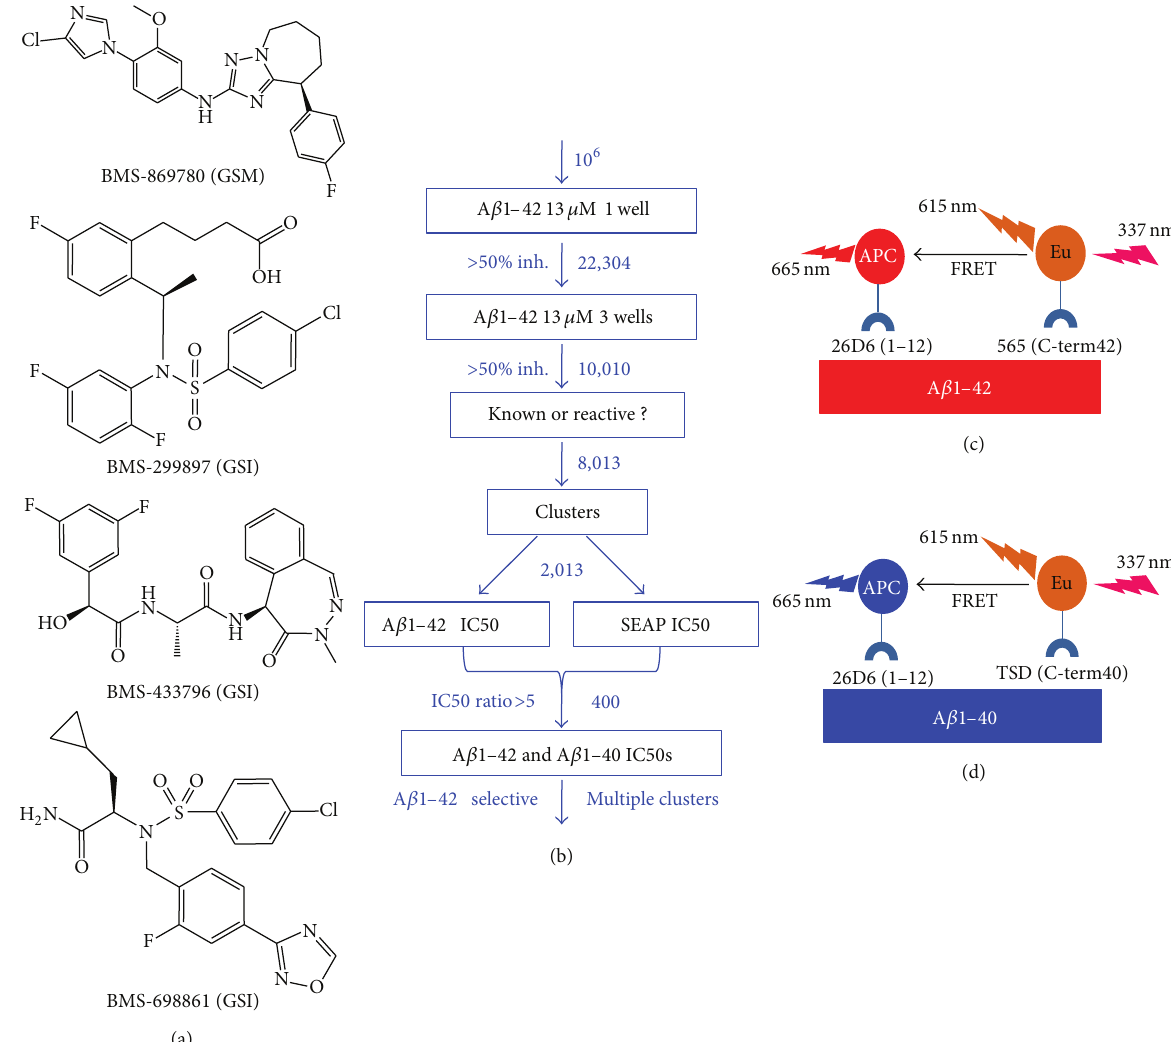
Figure 1: (a) Chemical structures of the compounds used in this study are shown. (b) Overview of the HTS and subsequent triage of compounds summarizes experimentation steps in boxes, with outcomes indicated beside the arrows. Costs of reagents and disposables were a major consideration in the design, particularly the initial screen of 10 6 samples. (c) Principle of the A 𝛽 1-42 immunoassay; simultaneous binding of monoclonal antibody conjugates 252-APC and 565-Eu (specific for C-terminus of A 𝛽 1-42) to A 𝛽 1-42 leads to FRET-based emission at 665 nm. The ratio of emission at 665 nm to fluorescence at 615nm represents the level of A 𝛽 1-42 in the sample. (d) Principle of the A 𝛽 1-40 immunoassay; same as described above for the A 𝛽 1-42 immunoassay, except that the monoclonal antibody conjugate TSD-Eu (specific for C-terminus of A 𝛽 1-40) was used in place of